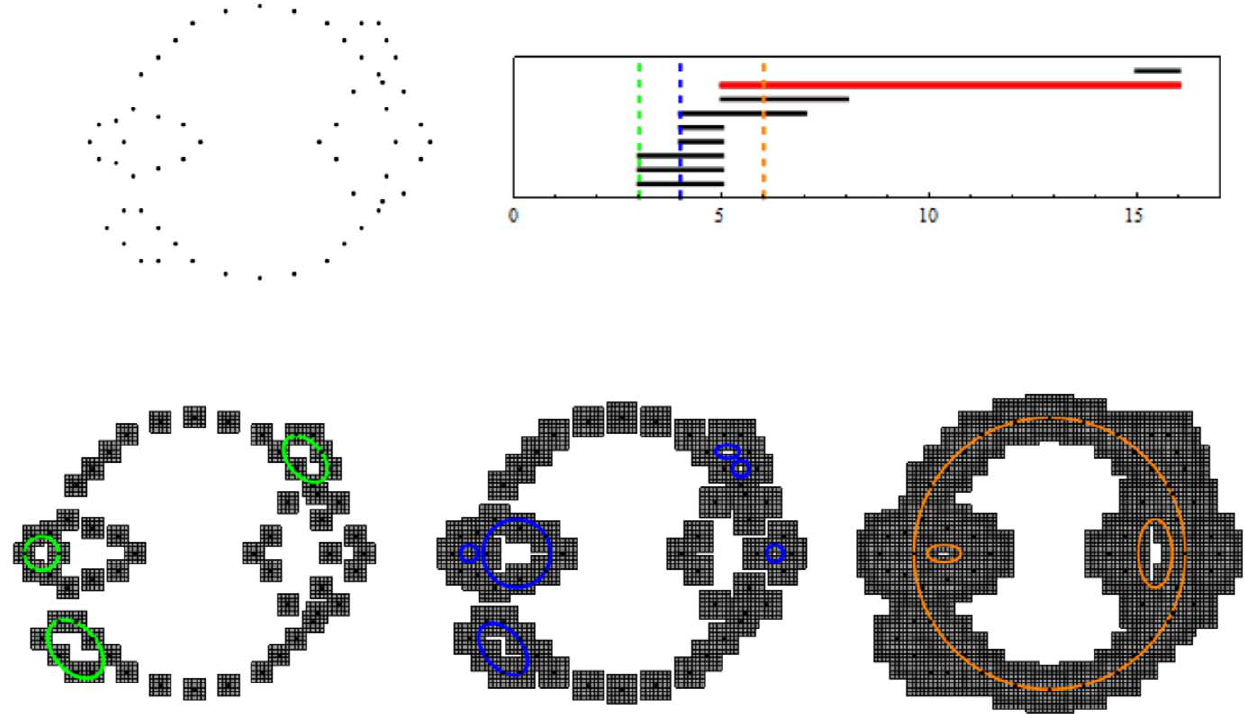
Figure 3. Persistent cubical homology. (Top, left) An example of a point cloud. (Bottom, left to right) As the size of the squares (in arbitrary units) around each point in the point cloud increases from 3 (left), through 4 (center) to 6 (right), different holes open and close in the gray set of squares. The colored circles around the holes represent generators of the first homology group, which are graphed as a function of the size in the barcode (top, right). The dashed lines are color coded and correspond to the figures in the bottom row. The red line in the barcode represents a persistent generator which indicates a hole that is present for a substantial range of sizes of the squares.